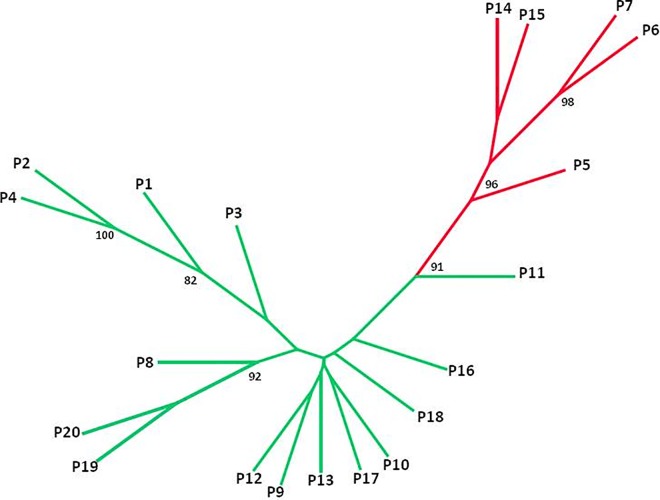
Unrooted neighbor-joining tree of S. purpurea populations based on Nei's genetic distance.Numbers at nodes are significant bootstrap support percentages from 1,000 replicates on loci. Colors correspond to K = 2.